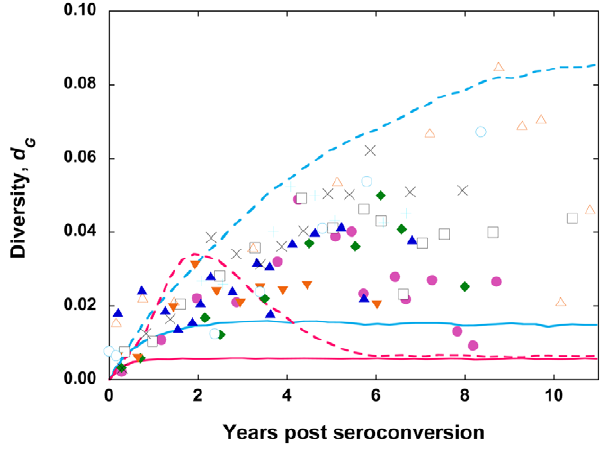
Figure 8. Simulations of viral genomic diversification with a multiplicative fitness landscape and comparisons with patient data. The evolution of viral diversity, d G , with generations predicted by our simulations (lines) for different population sizes C =200 (solid) and 10000 (dashed) with a multiplicative fitness landscape (see text) with s =0.01 (pink) and 0.001 (cyan). Each cell is assumed to be infected with M virions drawn from a distribution based on a viral dynamics model (see text). Different symbols are data from nine different patients [36] shown also in Figs. 3 and 7.